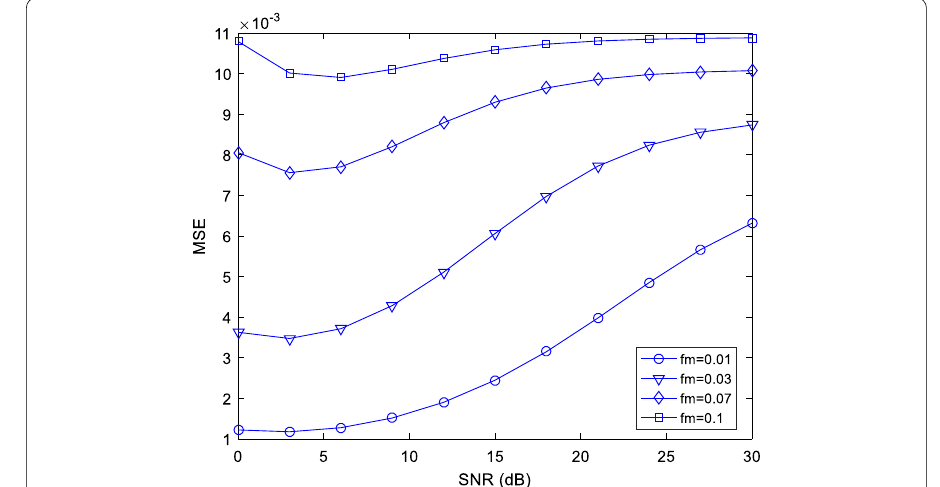
Fig. 2 The MSE of Doppler shift estimation: n/m